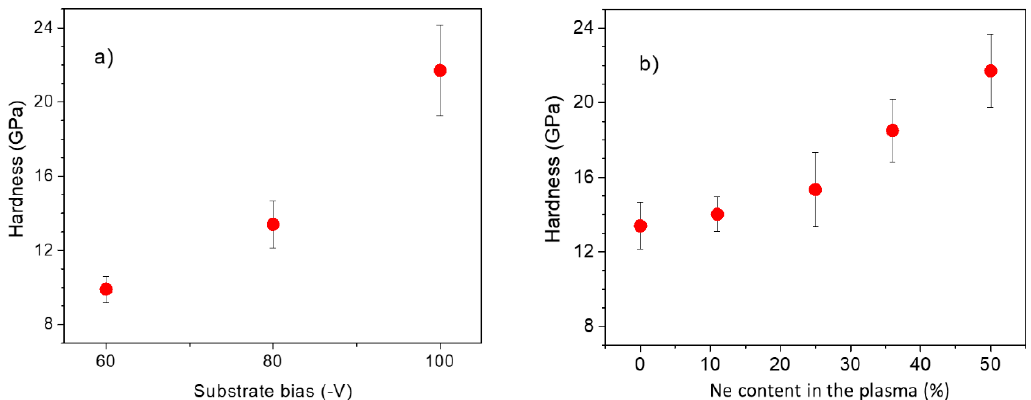
Figure 9. Hardness of the DLC coatings as a function of the substrate bias ( a ) and the Ne content in the plasma ( b ).